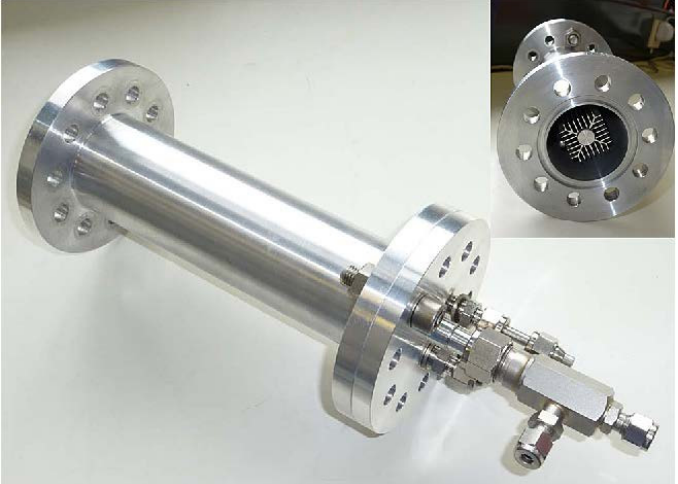
Figure 3. Al-Alloy hydrogen storage tank developed by Institut für Energie- und Umwelttechnik/Max-Planck-Institut für Kohlenforschung (IUTA/MPI). Reprinted with permission from reference [38]. Copyright 2014 Elsevier.